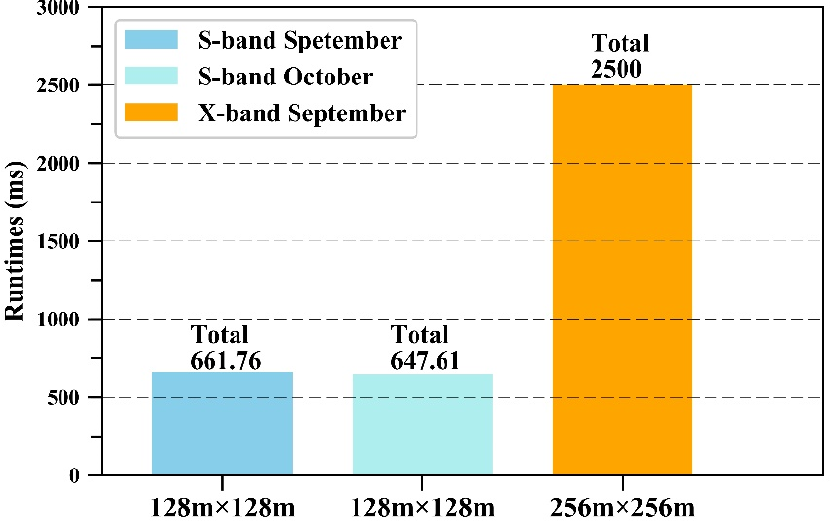
Figure 6. Processing time (ms) of high-performance parallel programs on different sizes of sea sur- face.